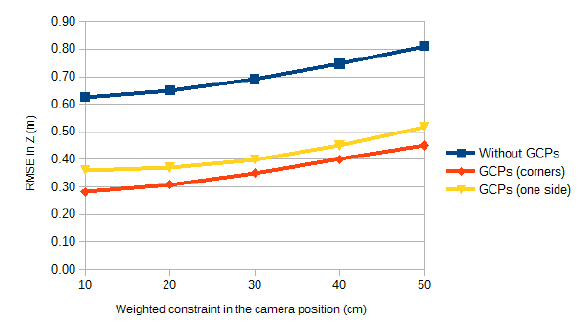
Figure 9. Sensor 2 – RMSE in Z coordinate calculated with four altimetry checkpoints in the